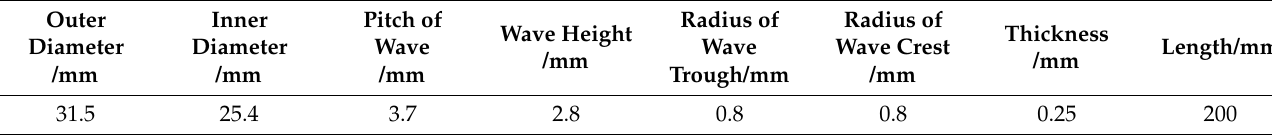
Table 3. Structural parameters of the metal bellows.